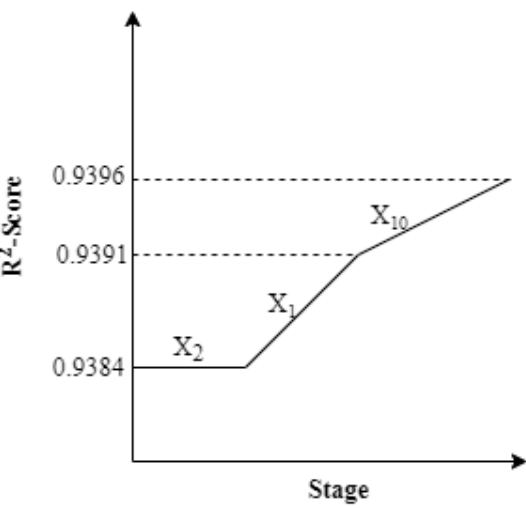
Figure 3. Example of the 1-Max_Out algorithm for the fish market problem.